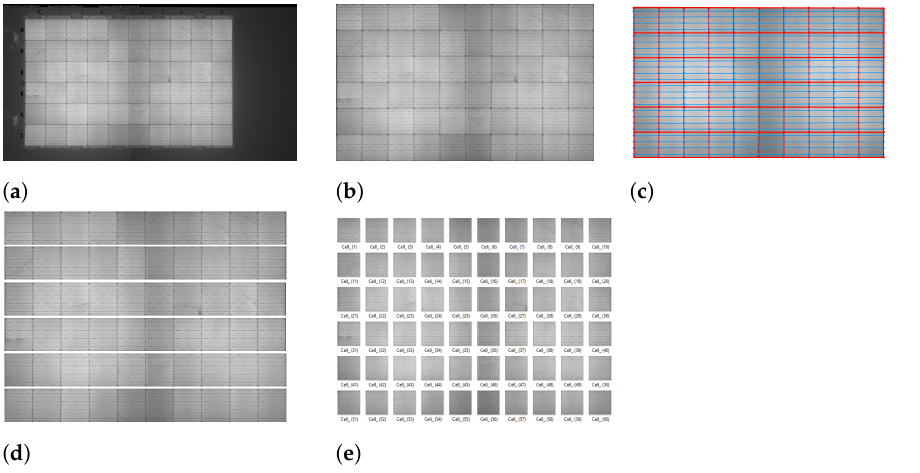
Figure 4. Pipeline for automatic cells segmentation in SCDD approach. ( a ) Original EL image of the PV module. ( b ) Panel region localization. ( c ) Gridlines and busbars identification. ( d ) Segmenting horizontal strip regions. ( e ) Segmenting individual cells.